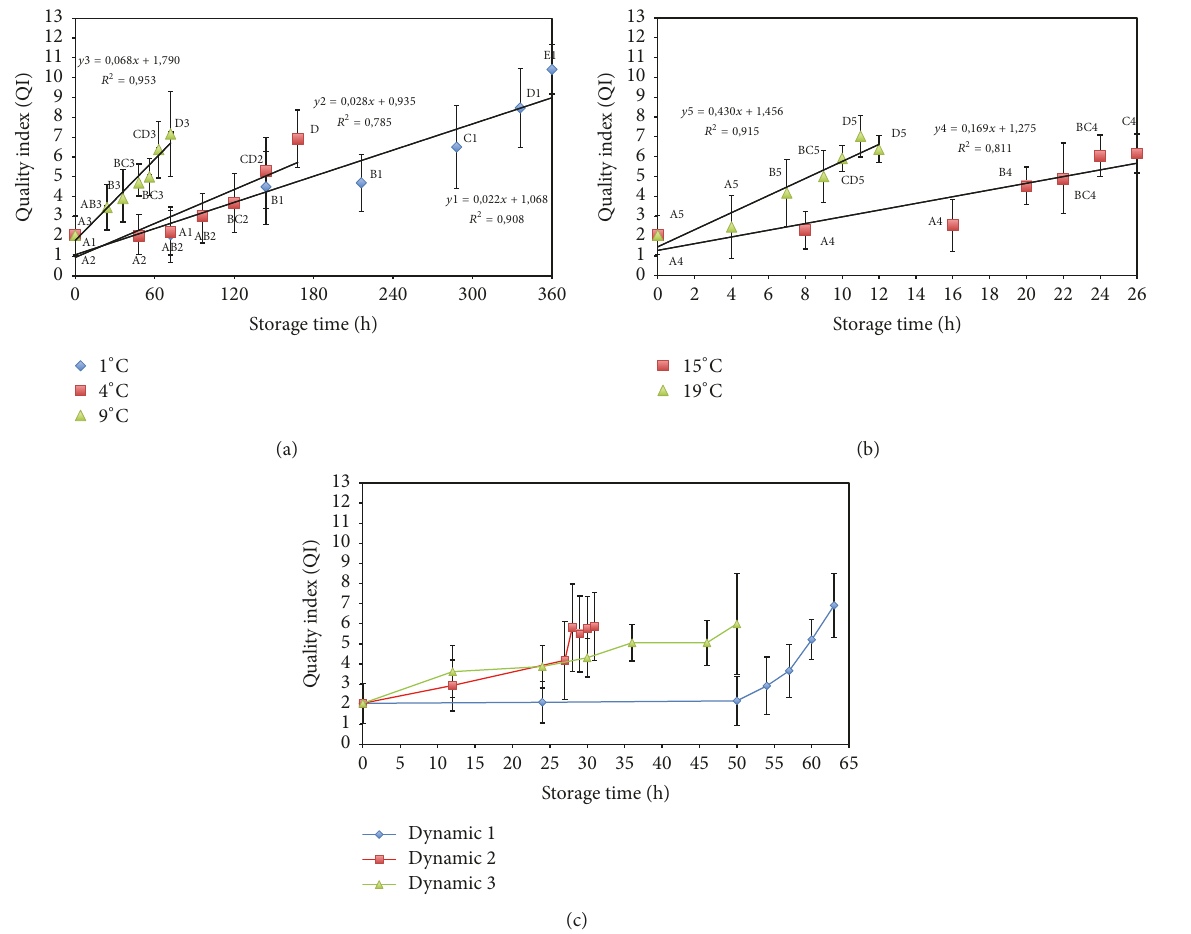
Figure 1: Changes in quality index (QI) of Pangasius fillets during storage at (a) 1, 4, and 9 ± 1 ∘ C, (b) 15 and 19 ± 1 ∘ C, and (c) dynamic temperature conditions. Different letters (A, B, C, D, and E) with numbers (1, 2, 3, 4, and 5) indicate significantly different QI mean values ( 𝑃 < 0.05 ) between samples over storage time of each temperature regime. In the regression equations, 𝑦 is QI and 𝑥 is storage time (h). and > 12 h at 19 ± 1 ∘ C. The QIM results at 1 ± 1 ∘ C